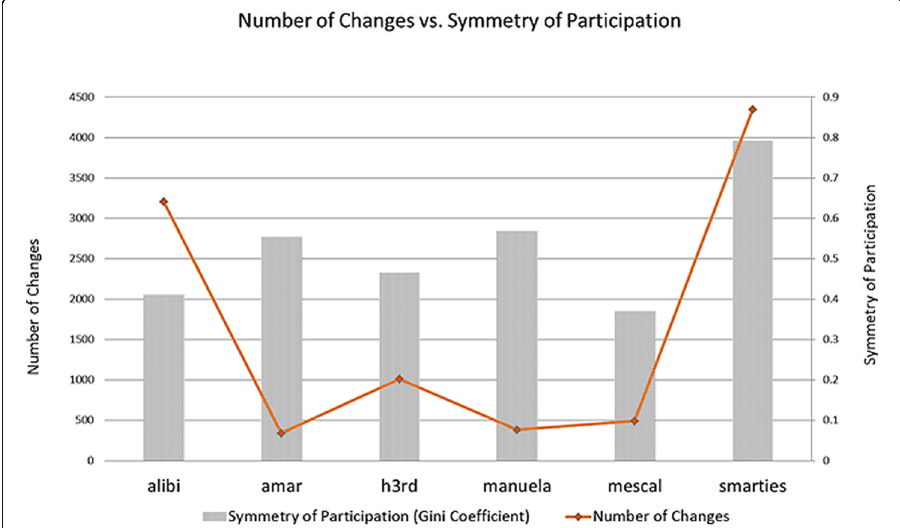
Fig. 2 Symmetry of participation (right axis, grey bars ) and number of changes (left axis, orange line ) for the six R&D projects of the Océ Dev